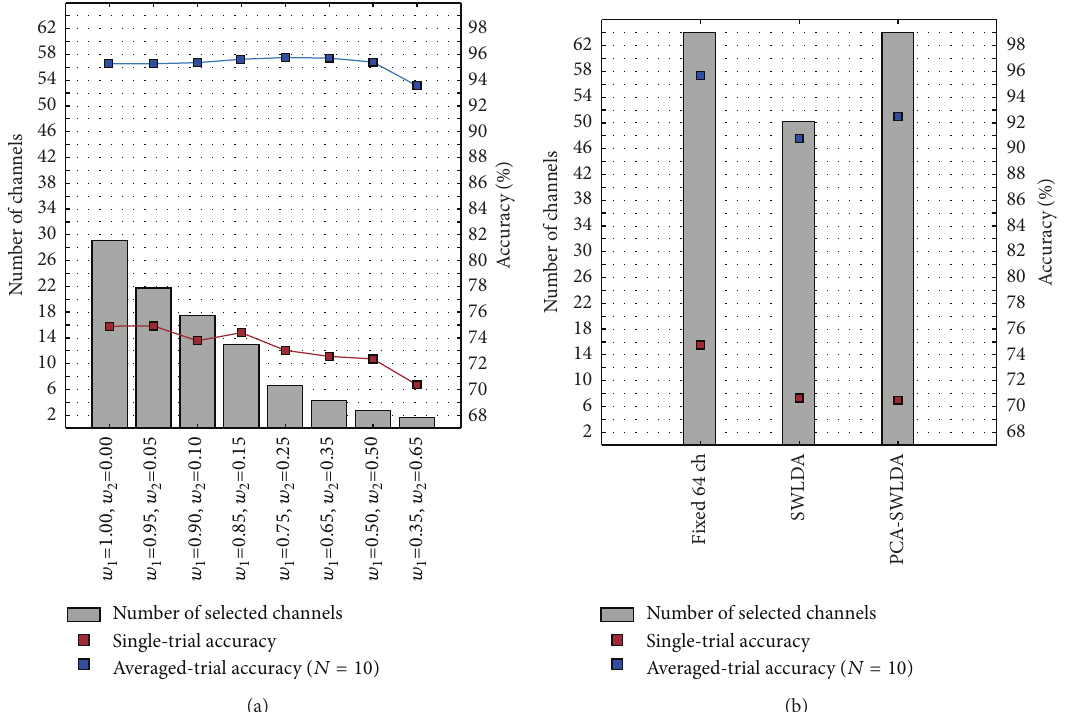
Figure 4: Number of selected channels (gray bars), single-trial (red line), and 10 averaged-trial (blue line) classification accuracy for (a) each MHPSO case and (b) the Fixed 64, SWLDA, and PCA-SWLDA cases.